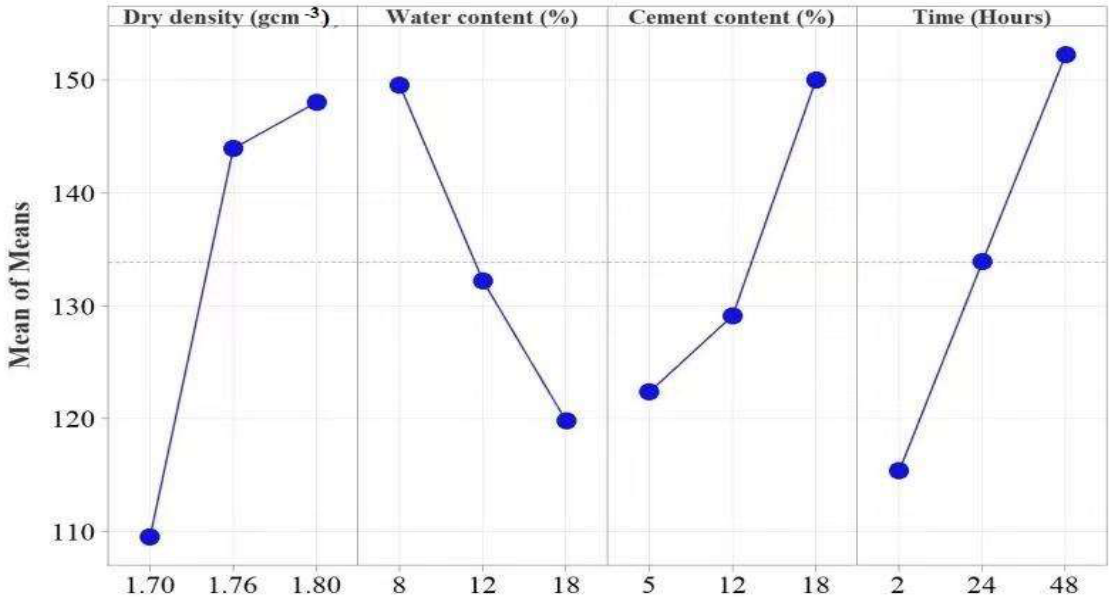
Figure 7. Effects of the control factors on the K